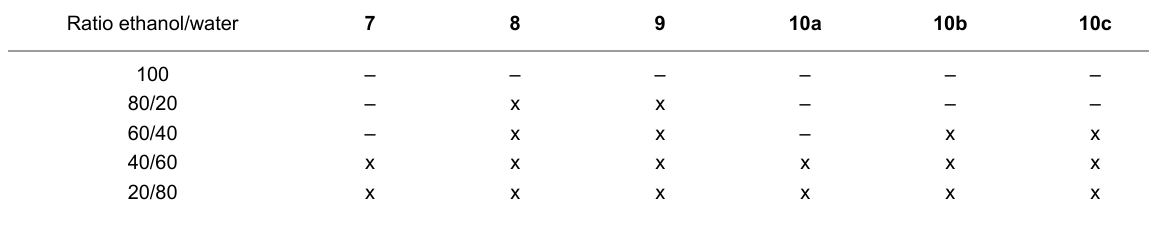
Table 4: Phase distribution in the coating solution at various ethanol/water ratios. “–“ : clear solution; “x” : opaque suspension. Ratio ethanol/water